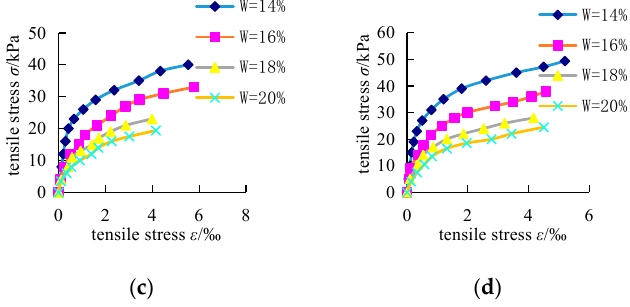
Figure 17. Tensile stress-strain curve of undisturbed soils: ( a ) ρ d = 1.28 g/cm 3 ; ( b ) ρ d = 1.37 g/cm 3 ; ( c ) ρ d = 1.46 g/cm 3 ; ( d ) ρ d = 1.53 g/cm 3 .